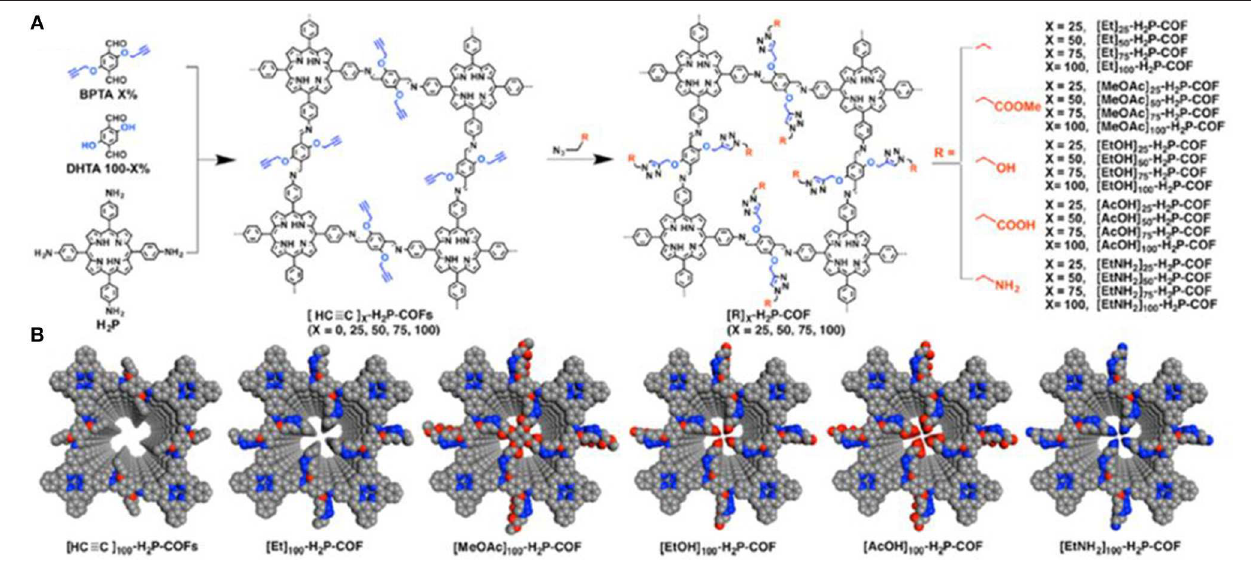
FIGURE 9 | (A) Installation of various functional groups onto the pore surface of an imine linked porphyrin COF as depicted by Huang et al. and (B) Pore structures of the synthesized COFs (Gray, C; Blue, N; Red, O). Reprinted with permission © 2015 The American Chemical Society.